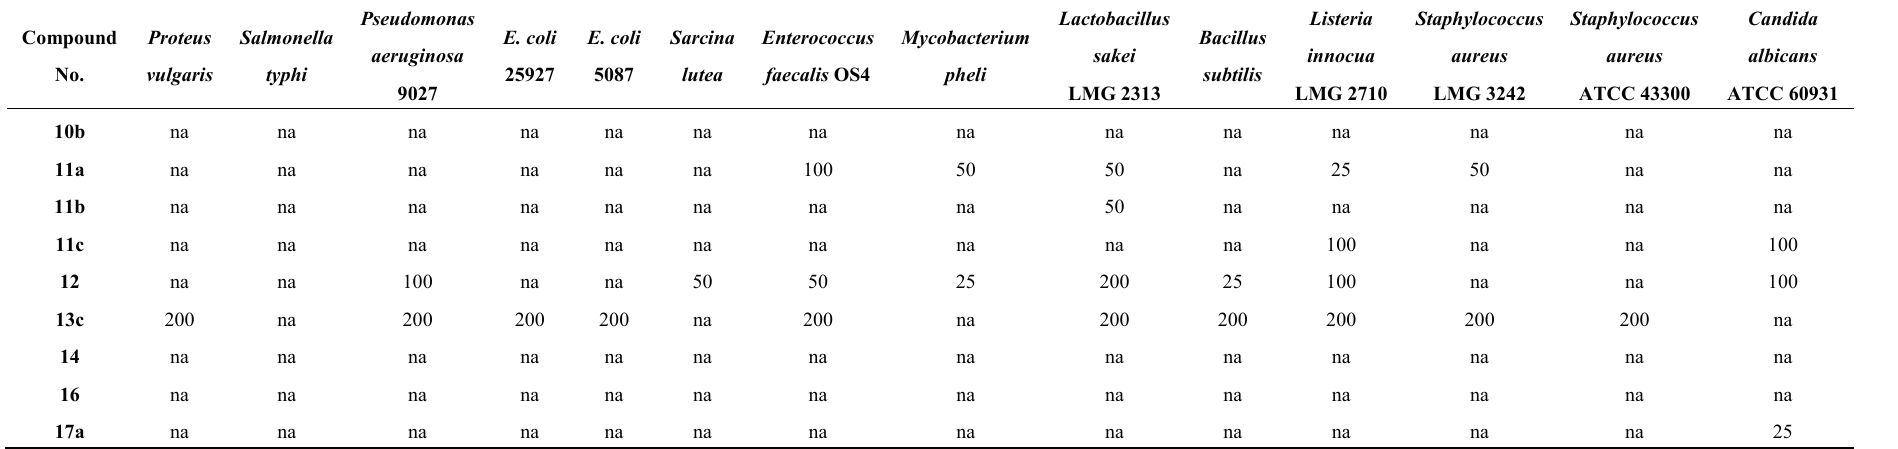
Table 2. MIC of samples against different microorganisms (µg/mL) * #